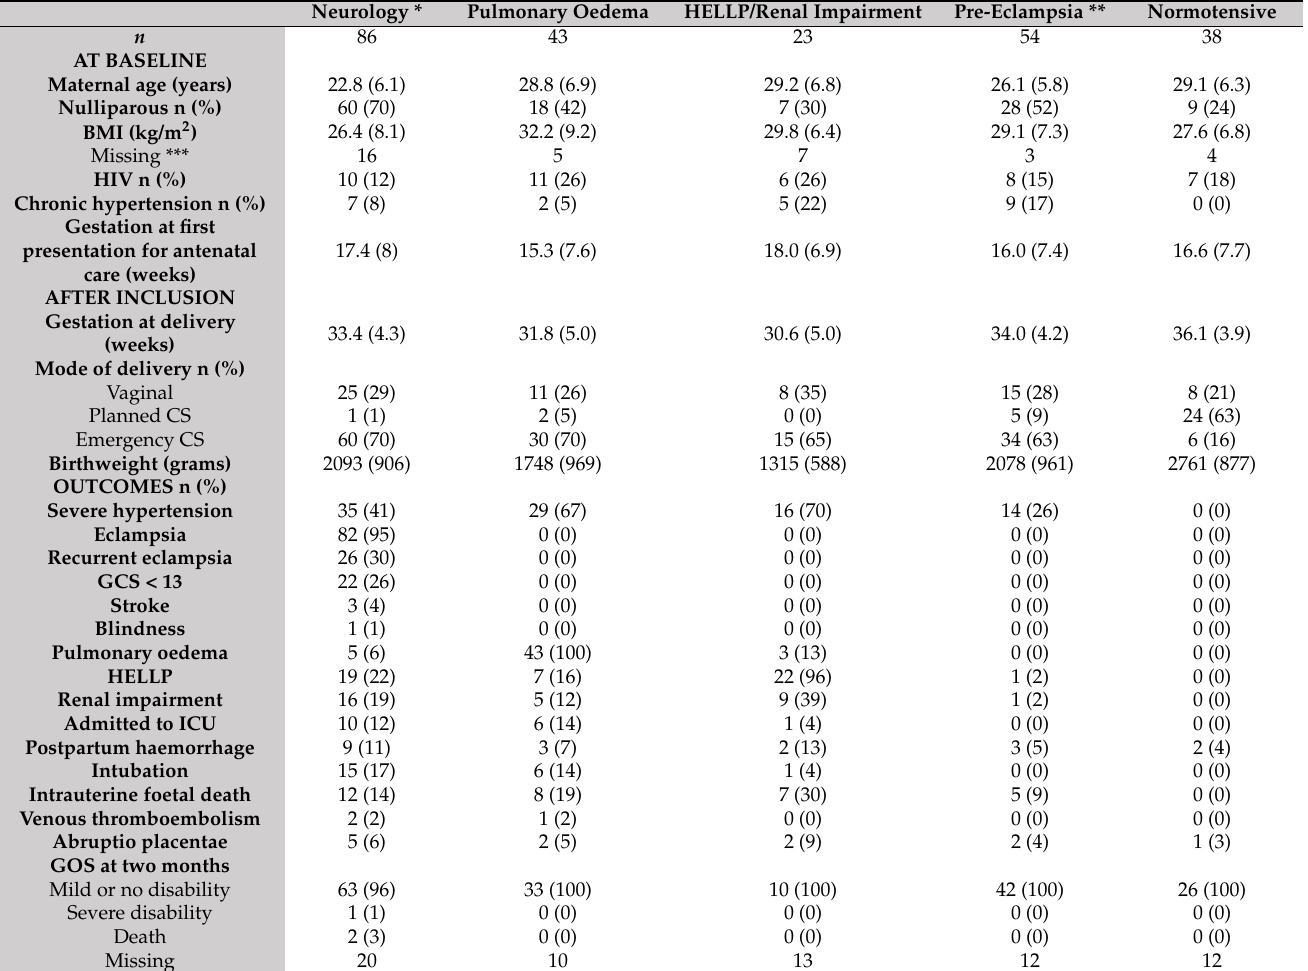
Table 3. Background characteristics of the women included in the biobank until March 2020, by complication at inclusion. Neurology